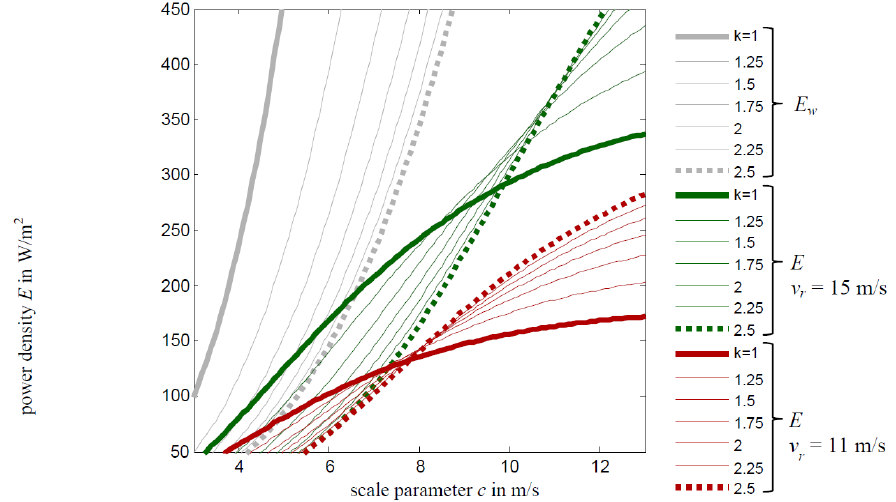
Figure 3. Power density E (at rated speeds v for different Weibull parameters. density E w